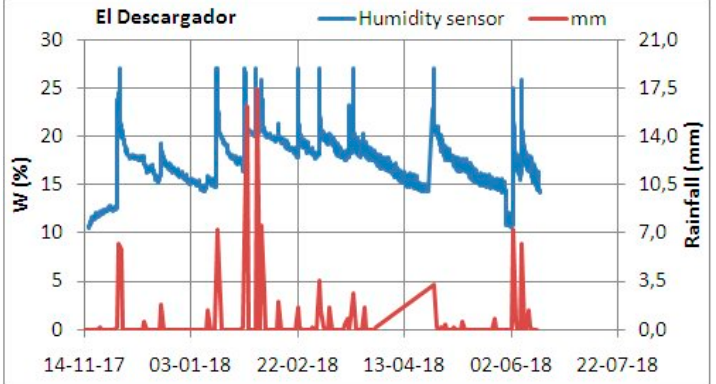
Figure 2. Connection between moisture and